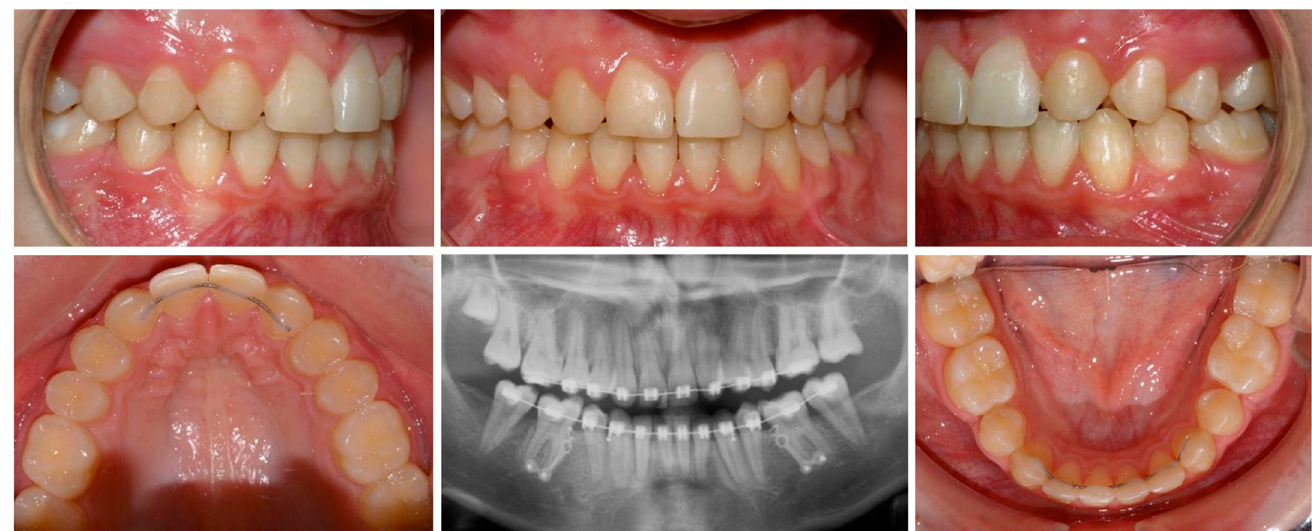
Figure 4. Pre-treatment photographs of a 14-year-old male with congenitally missing maxillary lat- eral incisors, and mandibular second premolars, retained mandibular second deciduous molars, cross bite between the maxillary and mandibular left canines, and minor mandibular anterior crowding.